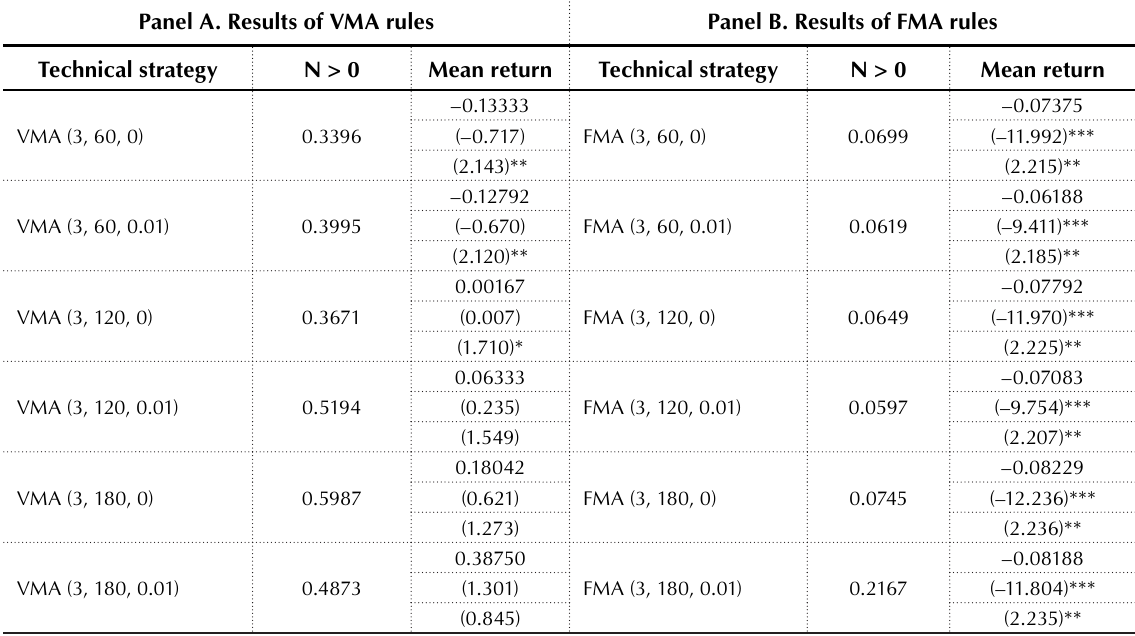
Table 3. VMA and FMA trading performance after the global financial crisis (2010–2013) Panel A. Results of VMA rules Panel B. Results of FMA